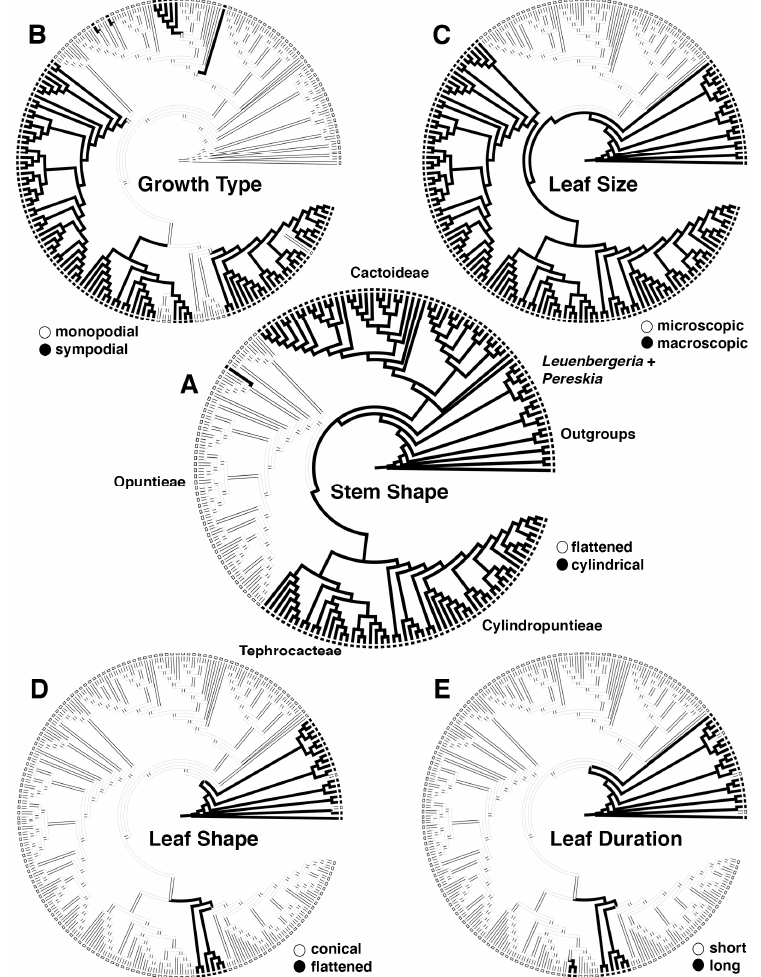
Figure 2. Morphological evolution in Cactaceae. ( A ) Cylindrical stems (black) were plesiomorphic, and Opuntieae displayed the synapomorphy (white) of flattened stems. ( B ) Monopodial stems (white) were plesiomorphic, and sympodial stems (black) evolved several times in Cactoideae, as well as in Opuntioideae, where there were also several changes back to monopodial growth. ( C ) Large, macroscopic (vegetative) leaves were plesiomorphic (black) in Cactaceae, but near-total leaf reduction was synapomorphic for Cactoideae. ( D ) Flattened (bifacial) leaves were ancestral in Cactaceae (black) and then re-evolved in Cylindropuntieae, and ( E ) long-lived leaves (black) were ancestral and then re-evolved in both Tephrocacteae and